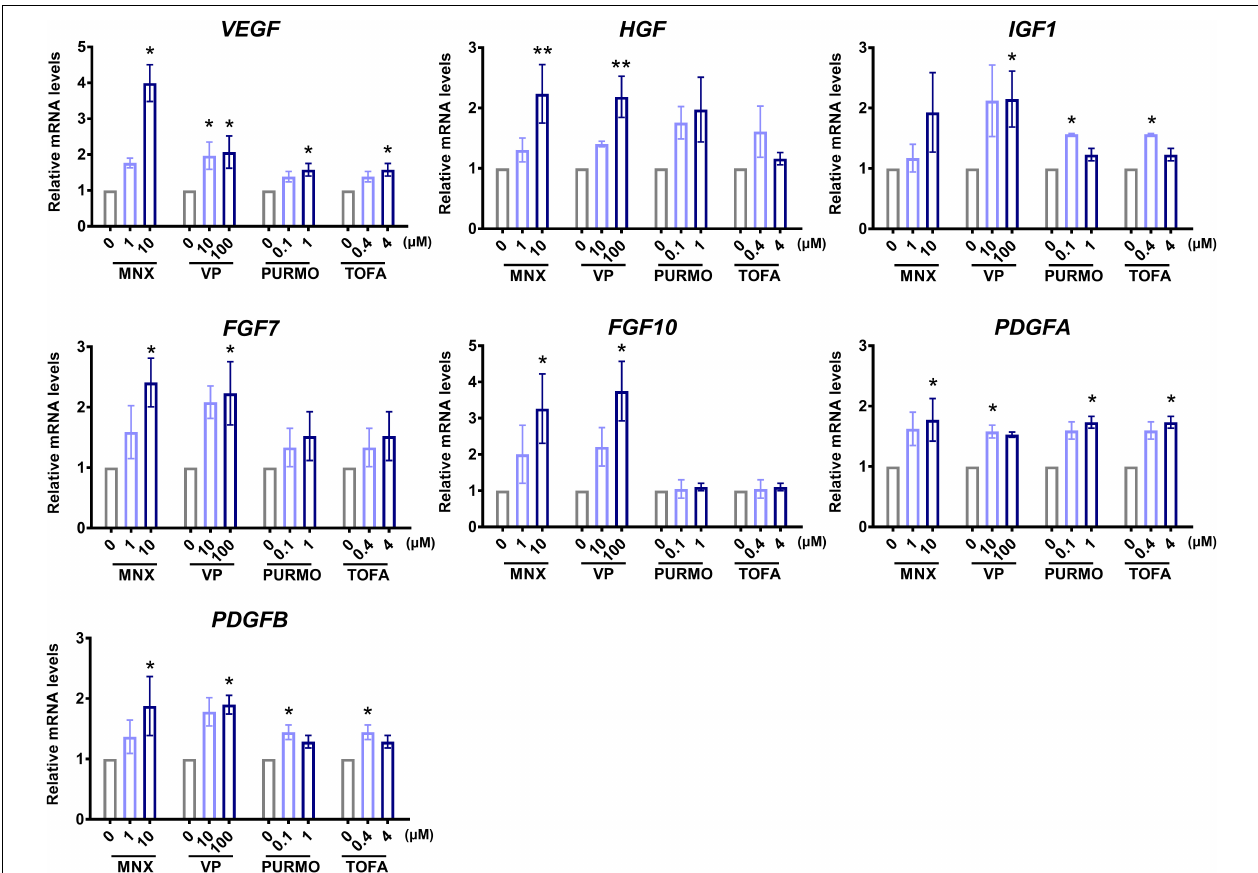
FIGURE 3 | Characterizations of biological functionality in the “two-cell assemblage (TCA)” structure. Quantitative analysis of changes in the expression of hair growth-associated genes of the TCA after treatment with minoxidil (MNX), valproic acid (VP), purmophamine (PURMO), or tofacitinib (TOFA). The expression levels of genes were normalized to levels of the reference gene, GAPDH. Data are presented as mean ± SEM and were evaluated using the Kruskal–Wallis test with Dunn’s multiple comparison test.* p < 0.05 or ** p < 0.01, compared to each control group (0 µ M). Three or four independent experiments were carried out for each